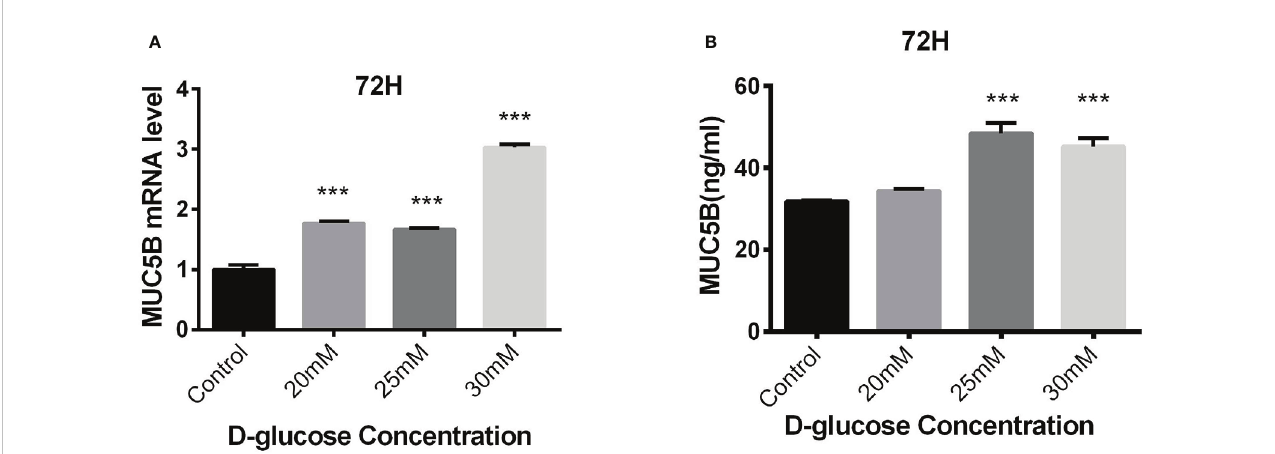
FIGURE 5 Effects of high glucose on the expression of MUC5B in BEAS-2B cells. (A) Compared with the control group, MUC5B mRNA in BEAS-2B cells were signi fi cantly increased after 20mM, 25mM and 30mM high-glucose stimulation for 72 hours (*** P < 0.001). (B) Compared with the control group,MUC5B in the supernatant were signi fi cantly increased after 25mM and 30mM high-glucose stimulation for 72 hours (*** P <